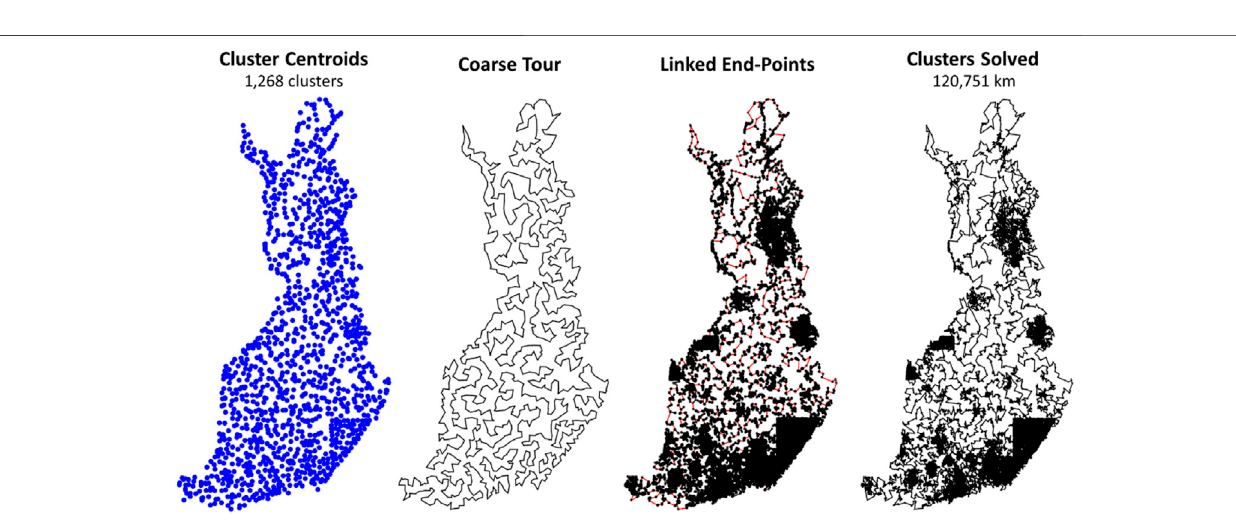
FIGURE 11 | Intermediate steps of DoLoWire